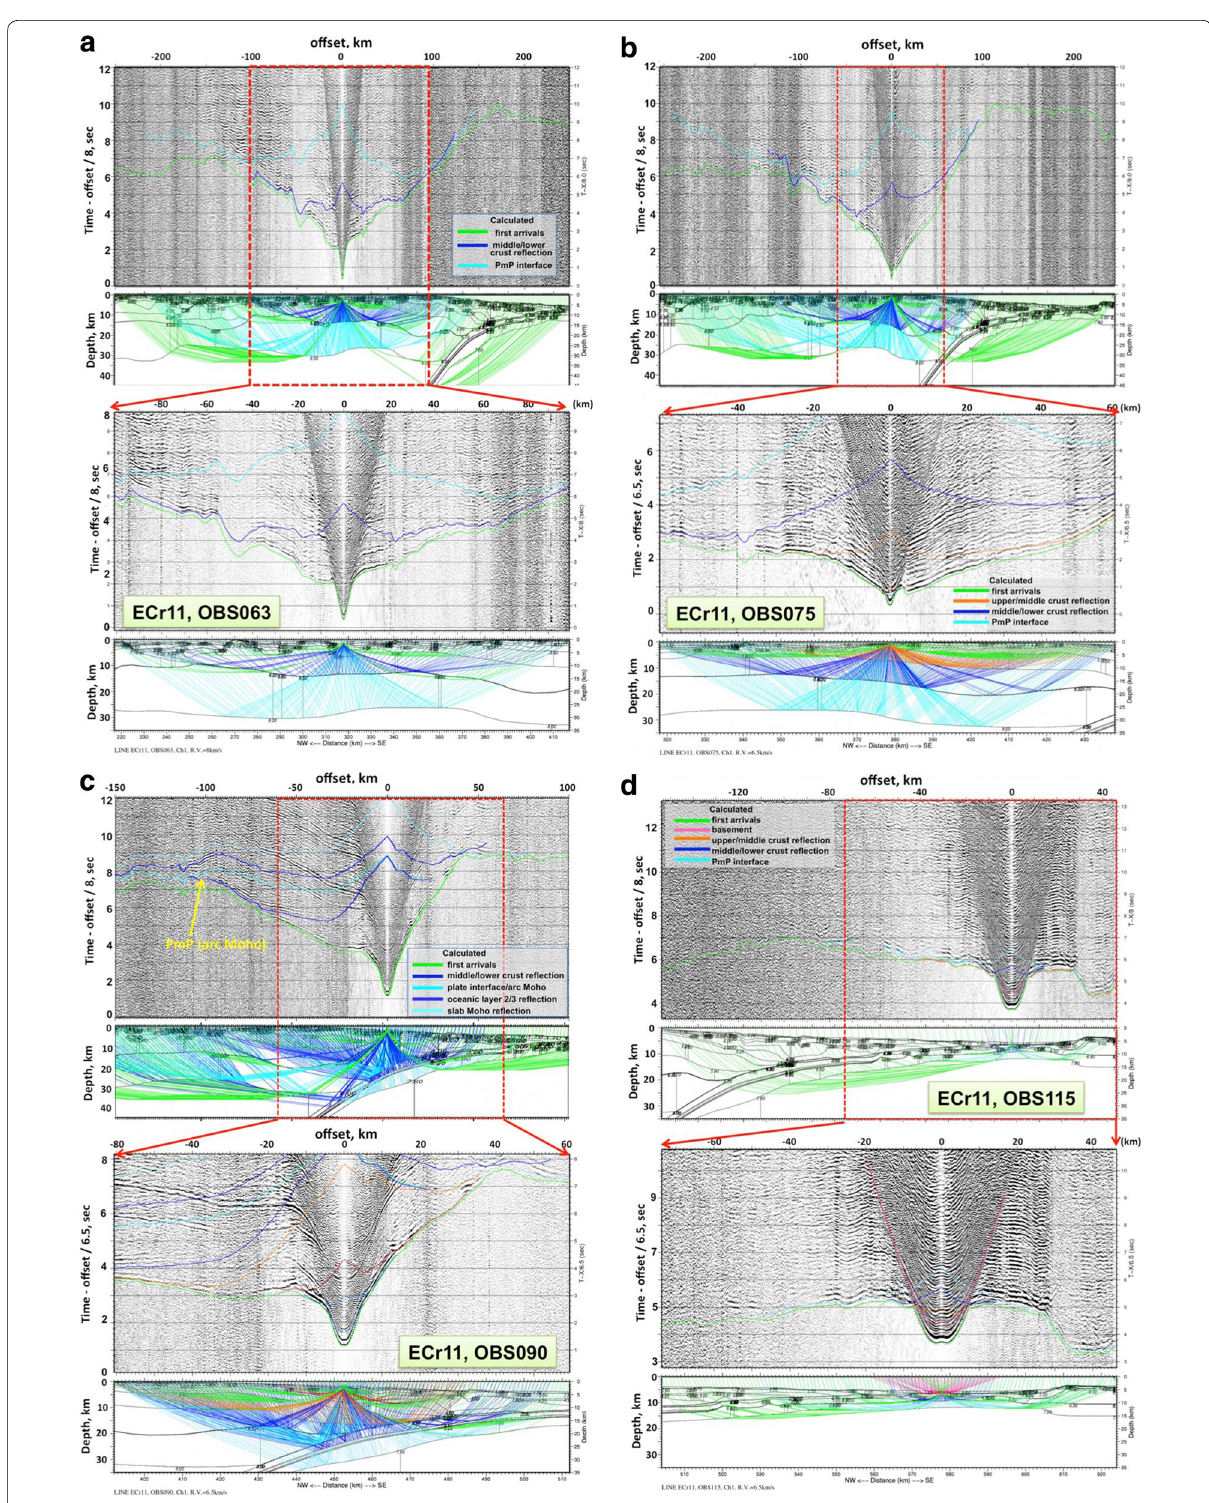
Fig. 6 Example of forward modeling for ECr11. a OBS063, b OBS075, c OBS090, d OBS115. Vertical record sections with calculated travel times and ray diagram are shown for each OBS. The OBS data were processed through predictive deconvolution and band-pass filtered (4–20 Hz). A gain factor proportional to distance has been used to enhance the distant seismograms. The color of the calculated travel times corresponds to the ray path in the ray